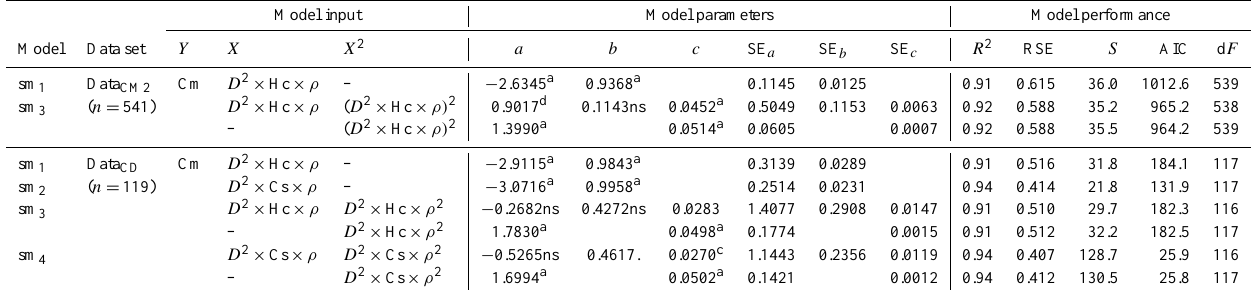
Table 1. Crown mass sub-models. Model variables are Cm (crown mass, kg), D (diameter at breast height,cm), Hc (crown depth, m), Cs (average of Hc and crown diameter, m) and ρ (wood density, gcm − 3 ) . The general form of the models is ln( Y) = a + b × ln (X) + c × ln (X) 2 . Model coefficient estimates are provided along with the associated standard error, which is denoted by SE i , with i as the coefficient.